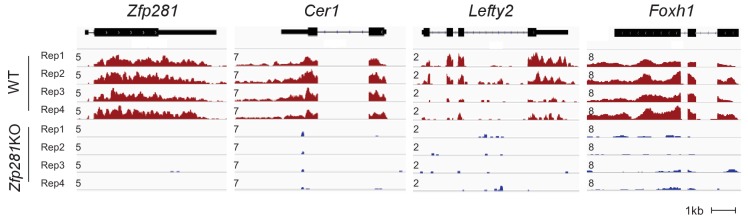
RNA-seq tracks of Zfp281 and Nodal signaling components.RNA-seq tracks of Zfp281 and components of Nodal signaling (Cer1, Lefty2, and Foxh1) in WT and Zfp281KO embryos. Intensities from different embryos are shown as mapped reads per million total mapped reads (RPM).